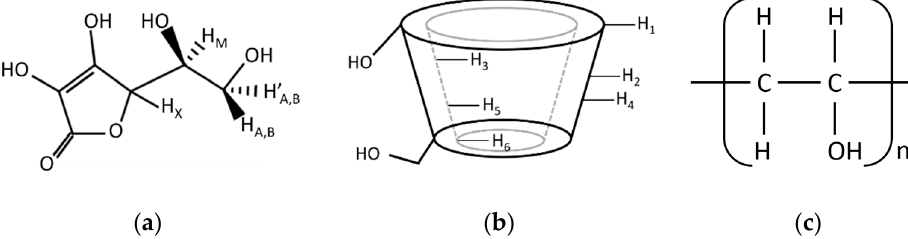
Figure 2. Stereo-chemical configuration of ascorbic acid ( a ), γ -cyclodextrin with internal and external protons ( b ), and poly(vinyl alcohol) ( c ). Table 2. Chemical shifts of ascorbic acid (AA), γ CD, and PVA in binary and ternary complexes.